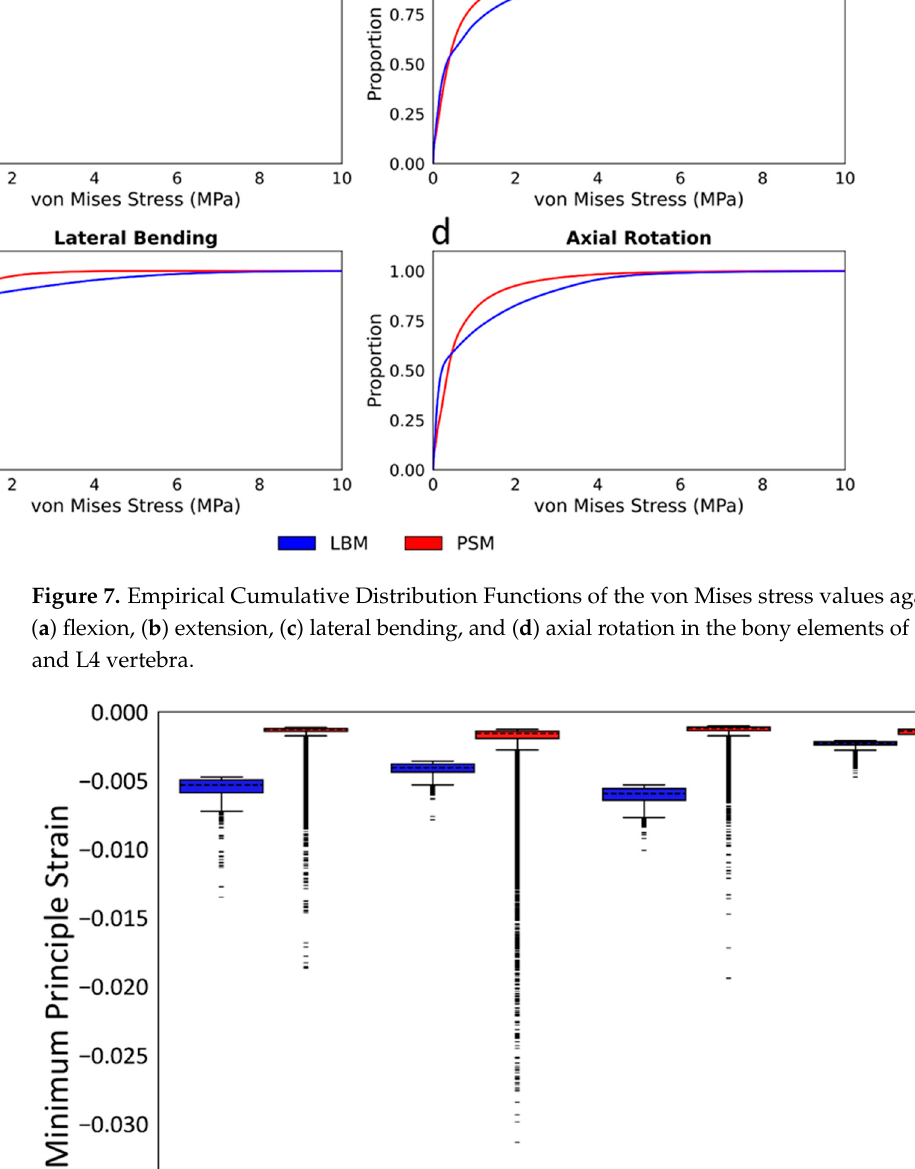
Figure 7. Empirical Cumulative Distribution Functions of the von Mises stress values against pure ( a ) flexion, ( b ) extension, ( c ) lateral bending, and ( d ) axial rotation in the bony elements of the L2, L3, and L4 vertebra.